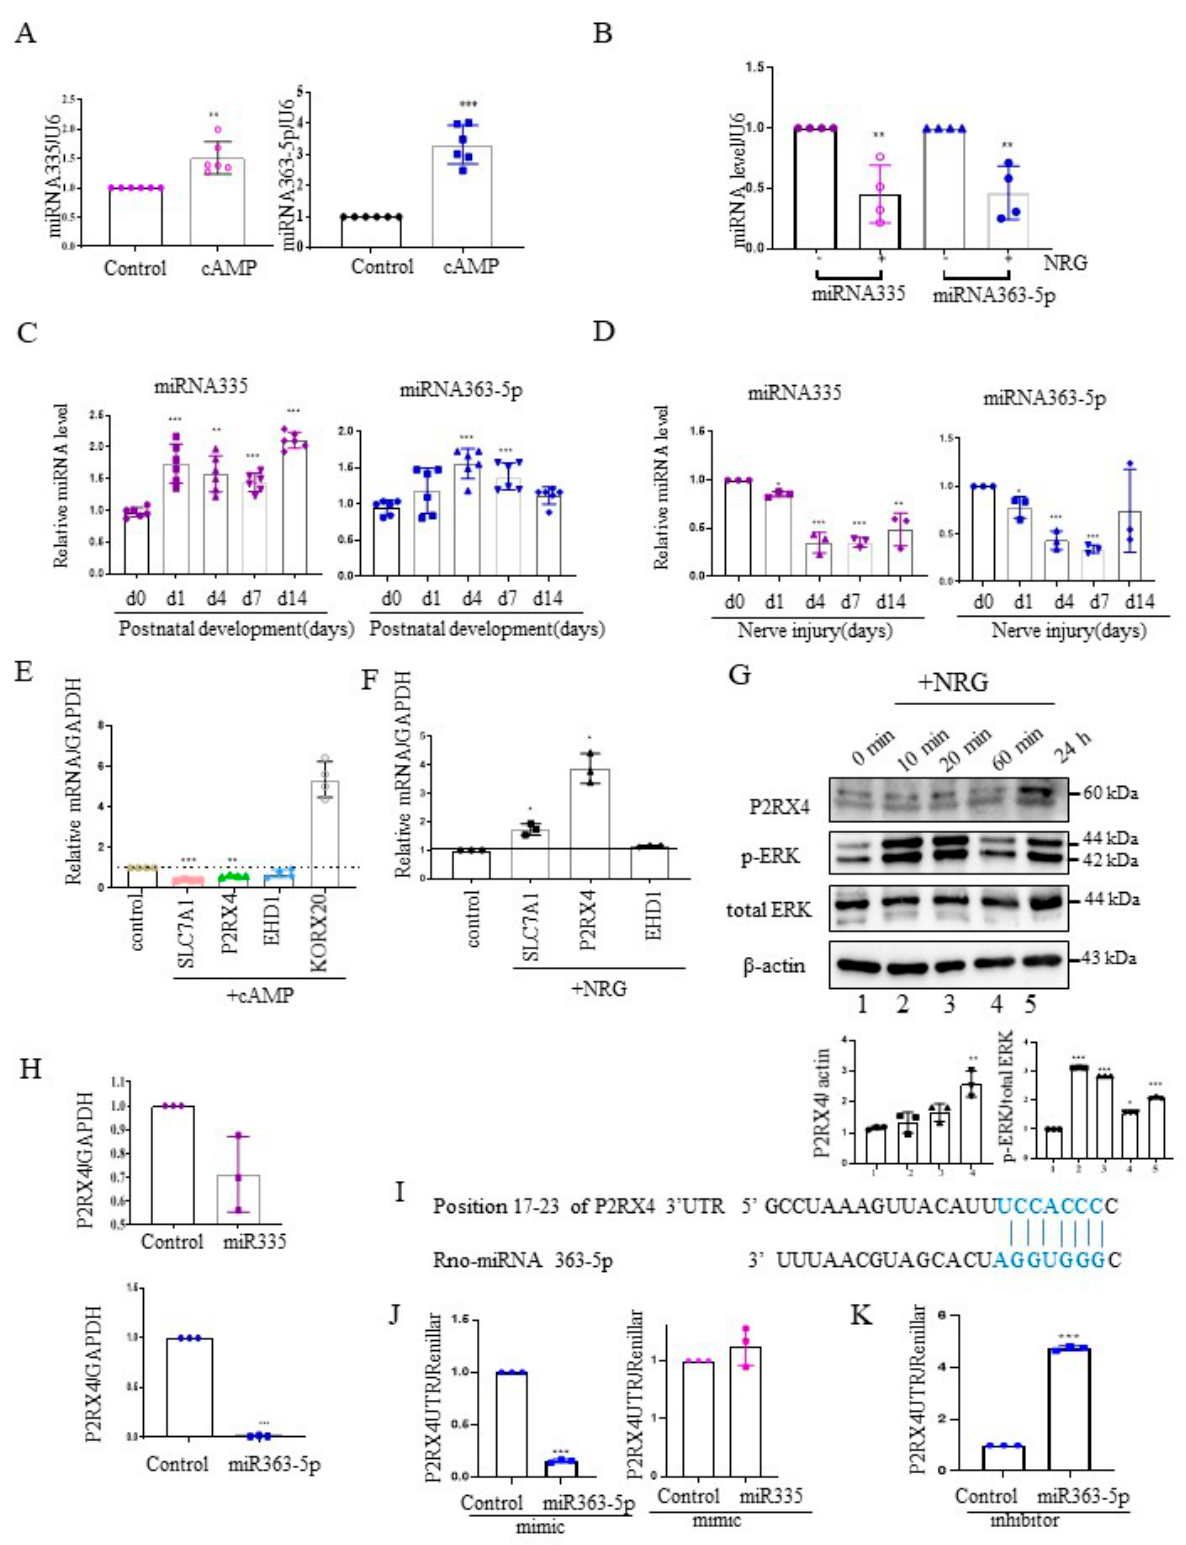
Figure 2. P2RX4 is a direct target of miRNA363-5p. ( A ) cAMP-induced Schwann cells exhibited an increased expression of miRNA335 and miRNA363-5p. n = 5. ( B ) NRG-treated Schwann cells exhibited a reduced expression of miRNA335 and miRNA363-5p. n = 4. ( C ) The expression levels of miRNA335 and miRNA363-5p increased during postnatal development.